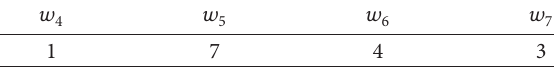
Table 25: Tabular representation of 5-ROFS